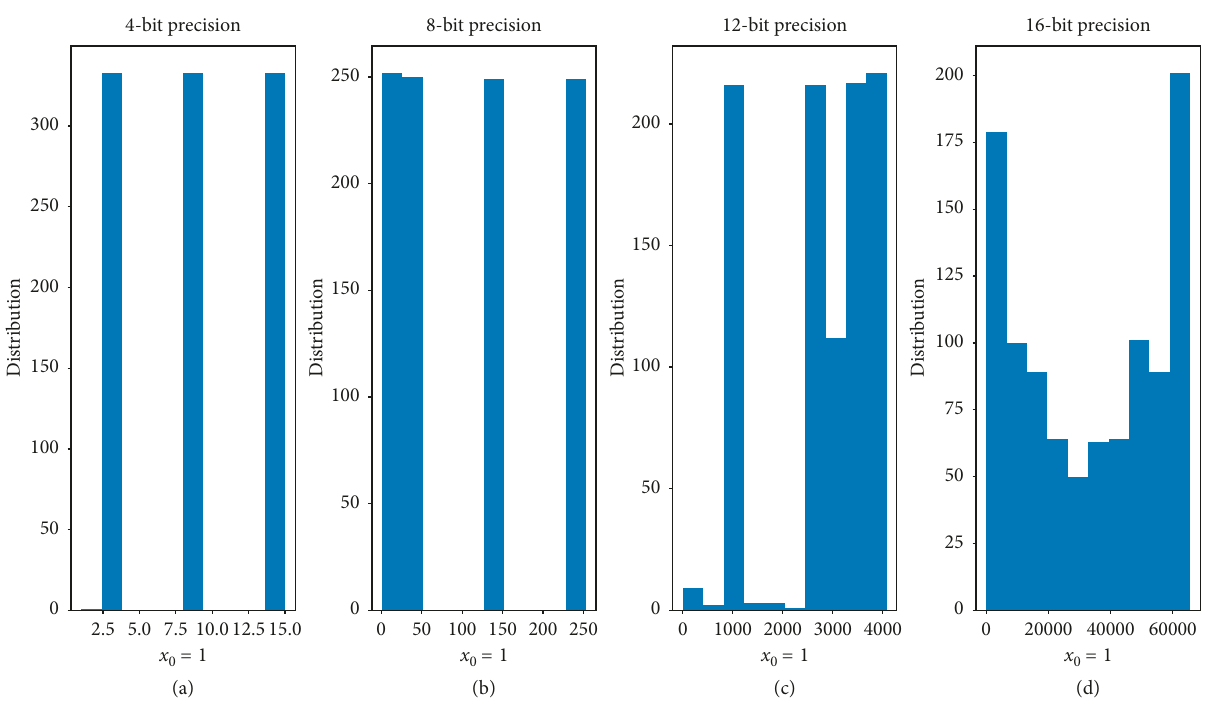
Figure 3: Distribution with different precision.